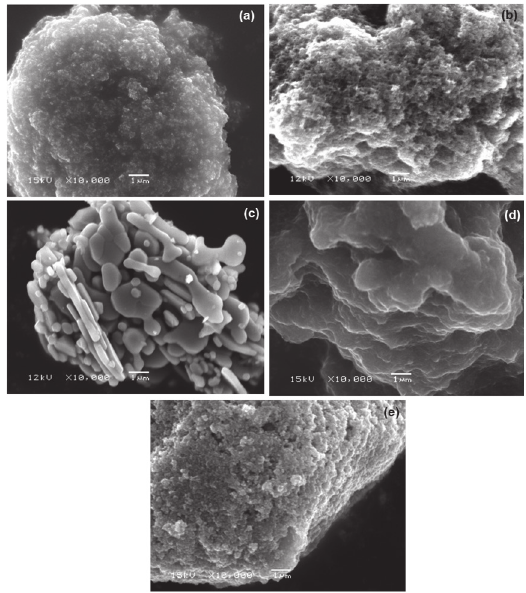
Figure 2: Scanning electron microscope (SEM) images of (a) commercial